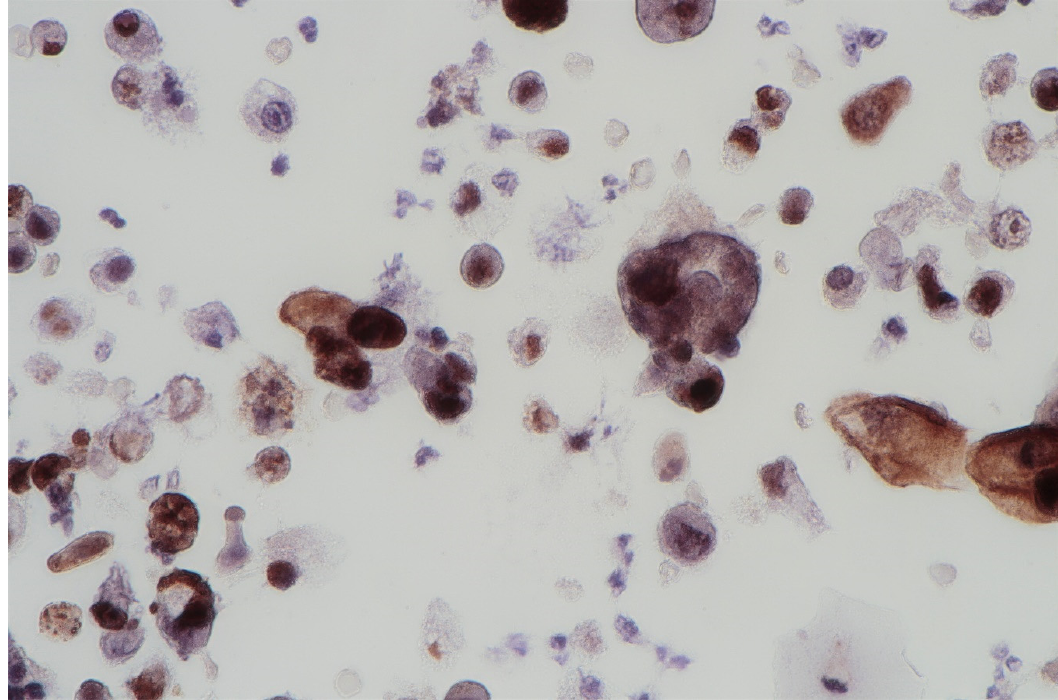
Figure 2. Urine sediment—a cytological specimen. The immunocytochemical reaction of p53. A dominating picture of positive p53 reactions, both nuclear and cytoplasmatic. Single large cells are filled with haemosiderin.